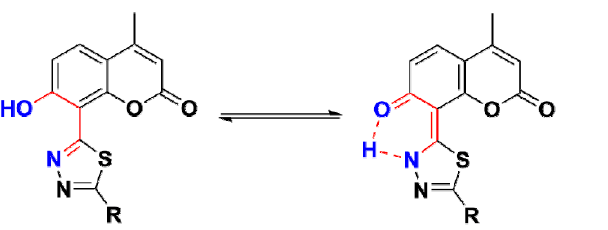
Figure 4. Proposed enol ( left ) and keto ( right ) tautomeric forms of the coumarin-thiadiazole hybrids 2 – 5